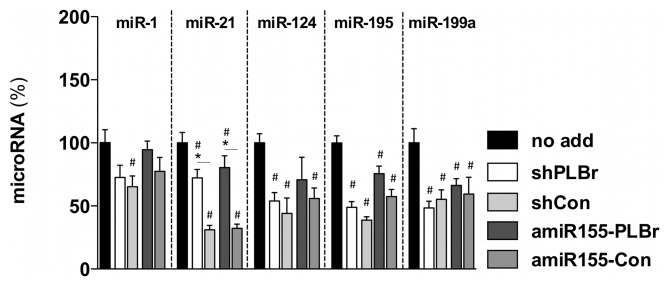
Alteration of miR expression in scAAV6-amiR155-PLBr and scAAV6-shPLB transduced CM.Cells were transduced with 25×103 vg/c of either scAAV6-shPLBr (shPLBr), scAAV6-amiR155-PLBr (amiR155-PLBr) or control vectors (scAAV6-shCon (shCon) or scAAV6-amiR155-Con (amiR155-Con)). Cells were harvested at day 14 post transduction and qRT-PCR analysis was carried out. Expression values were normalized to the level of the U6snRNA and related to that obtained for untransduced cells; #p<0.05 vs. untransduced cells (no add); *p<0.05 vs. respective control vectors.